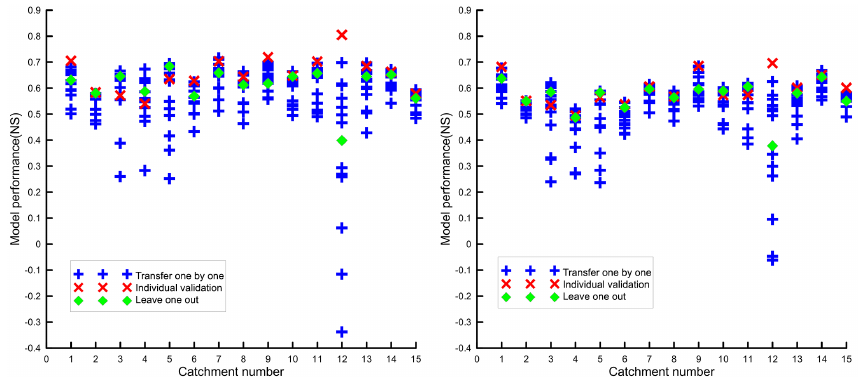
Figure 7. Mean NS model performance of the calibration, individual parameter transfer, and for the leave-one-out transfer for the selected 15 catchments for the validation time period 1991–2000. Left panel: HBV, right panel: